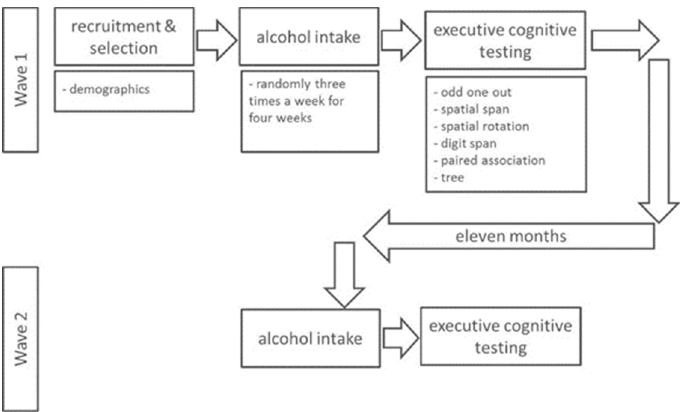
Figure 2. Study design.